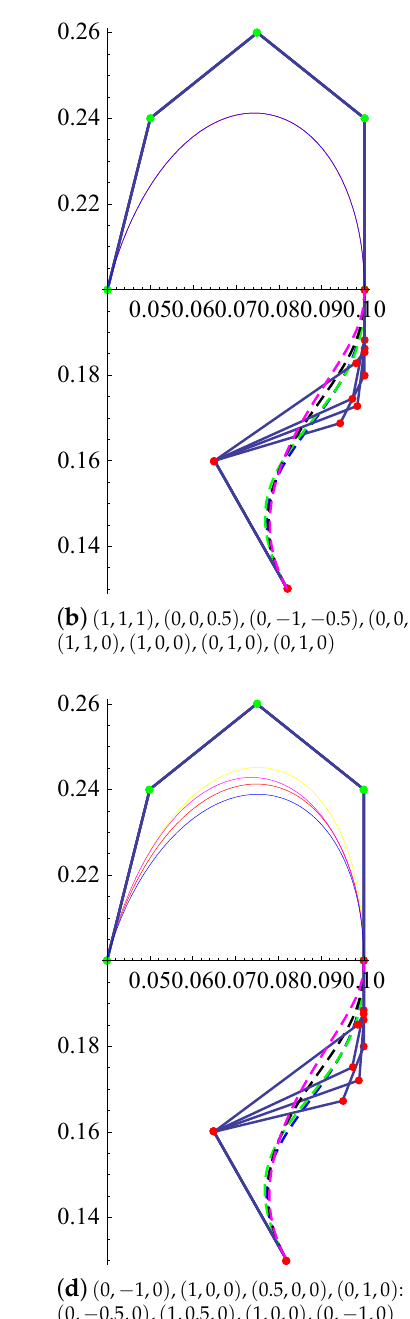
1,0 ) ; ( b ) ( 1,1,1 ) , ( 0,0,0.5 ) , − 0.7,0 ) , ( 0,0,0 ) , ( 0, −